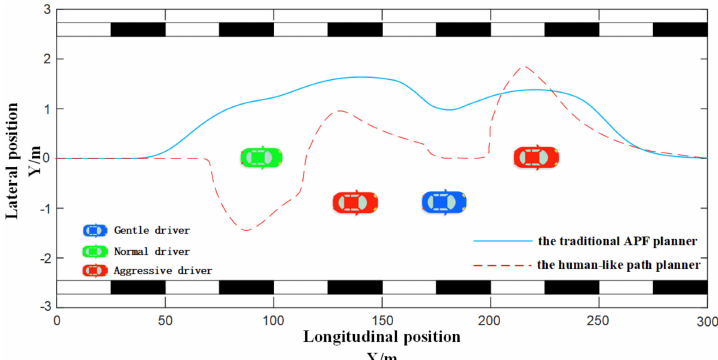
Figure 16. Path planning in overtaking scenes B with various